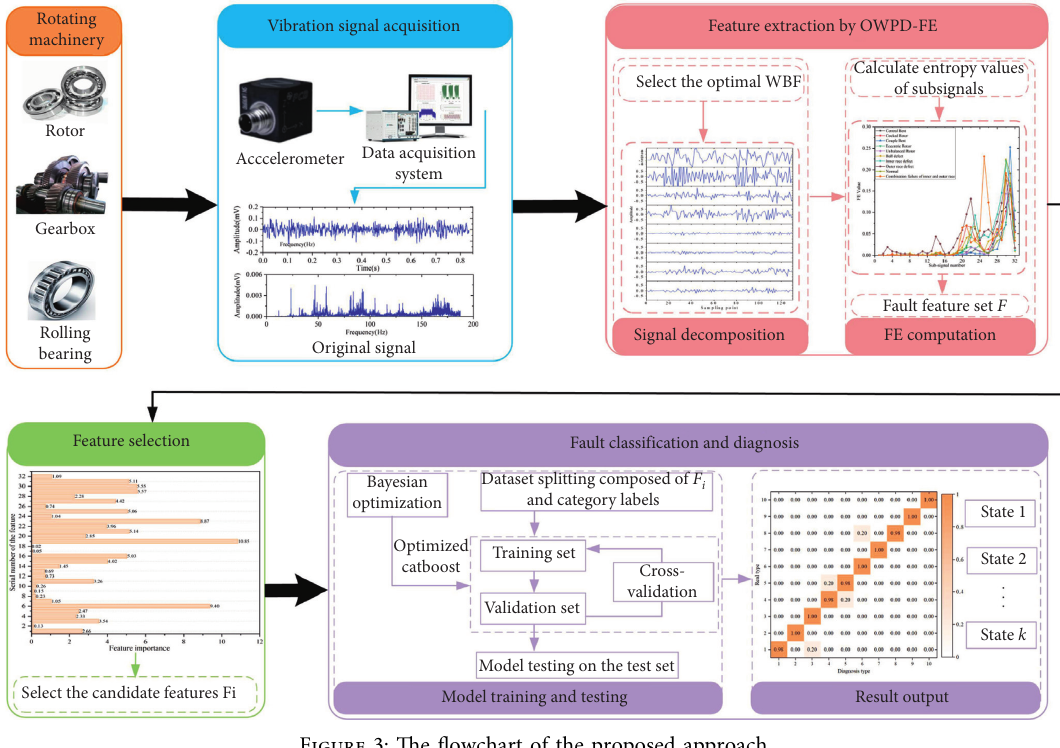
Figure 3: The flowchart of the proposed